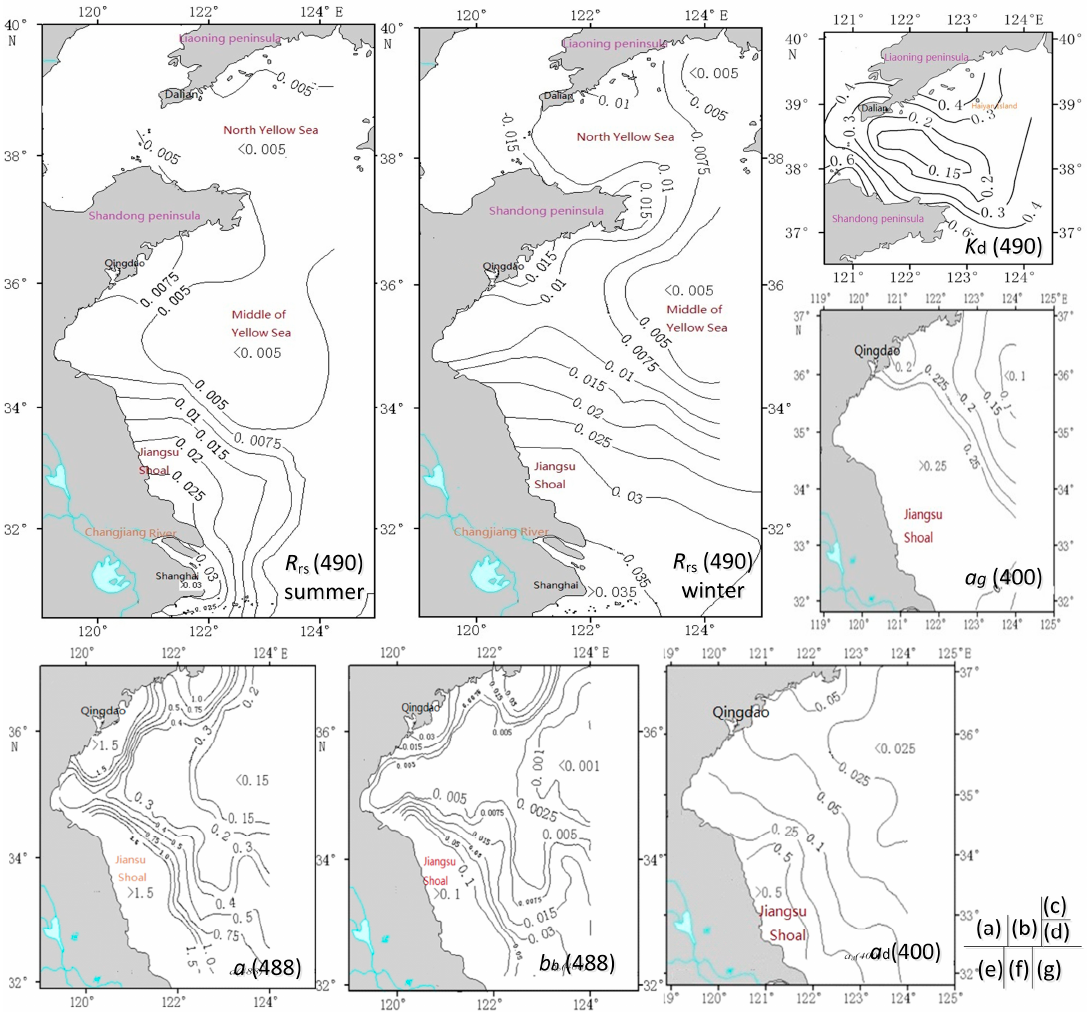
Figure 7. ( a – g ) Yellow Sea (YS) R rs (490) contour diagrams in ( a ) summer and ( b ) winter; ( c ) north Yellow Sea (NYS) K d (490) distribution diagram in autumn; ( e , f ) a (488) and b b (488) contour diagrams in winter; and ( d , g ) Jiangsu shoal (JS) a g (400) and a d (400) contour diagrams in summer.